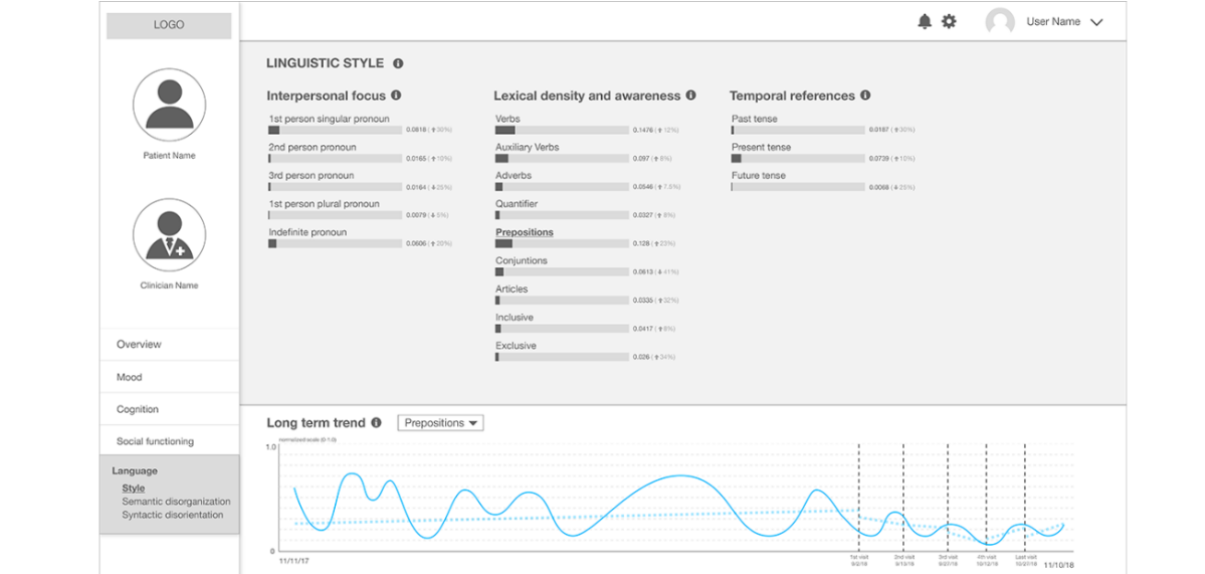
Figure 6. The second prototype: a clinical state and trend visualization interface – "Linguistic